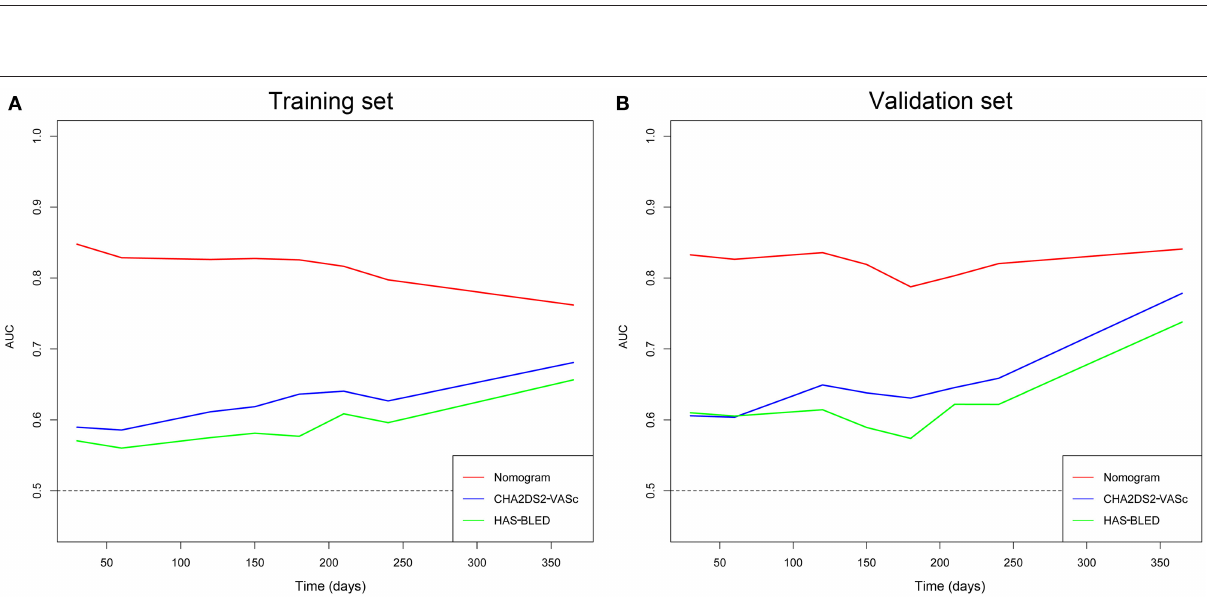
FIGURE 5 | Time-dependent ROC of the nomogram compared with CHA 2 DS 2 -VASc and HAS-BLED models in the training and validation sets. (A) Training set. (B) Validation